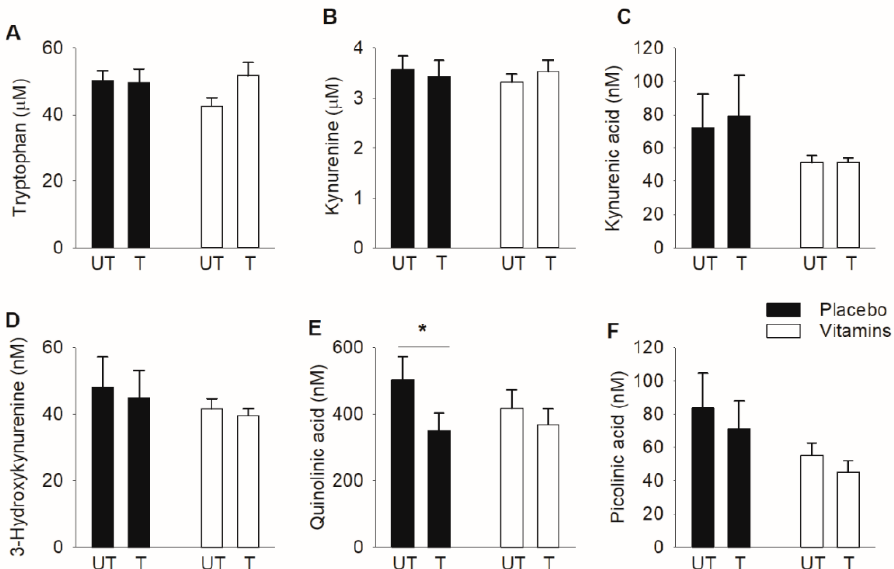
Figure 2. Effects of three weeks of SIT with or without antioxidant supplementation on KP metabolites in plasma of resting individuals. ( A ) Tryptophan, ( B ) kynurenine, ( C ) kynurenic acid, ( D ) 3-hydroxykynurenine, ( E ) quinolinic acid, and ( F ) picolinic acid in plasma in connection with the first (untrained, UT) and the last (trained, T) SIT sessions. Black bars, placebo group ( n = 9) and white bars, vitamin-treated group ( n = 11). Data presented as mean ± SEM. * p < 0.05 between untrained and trained state with two-way repeated measures ANOVA followed by Tukey’s post-hoc test.